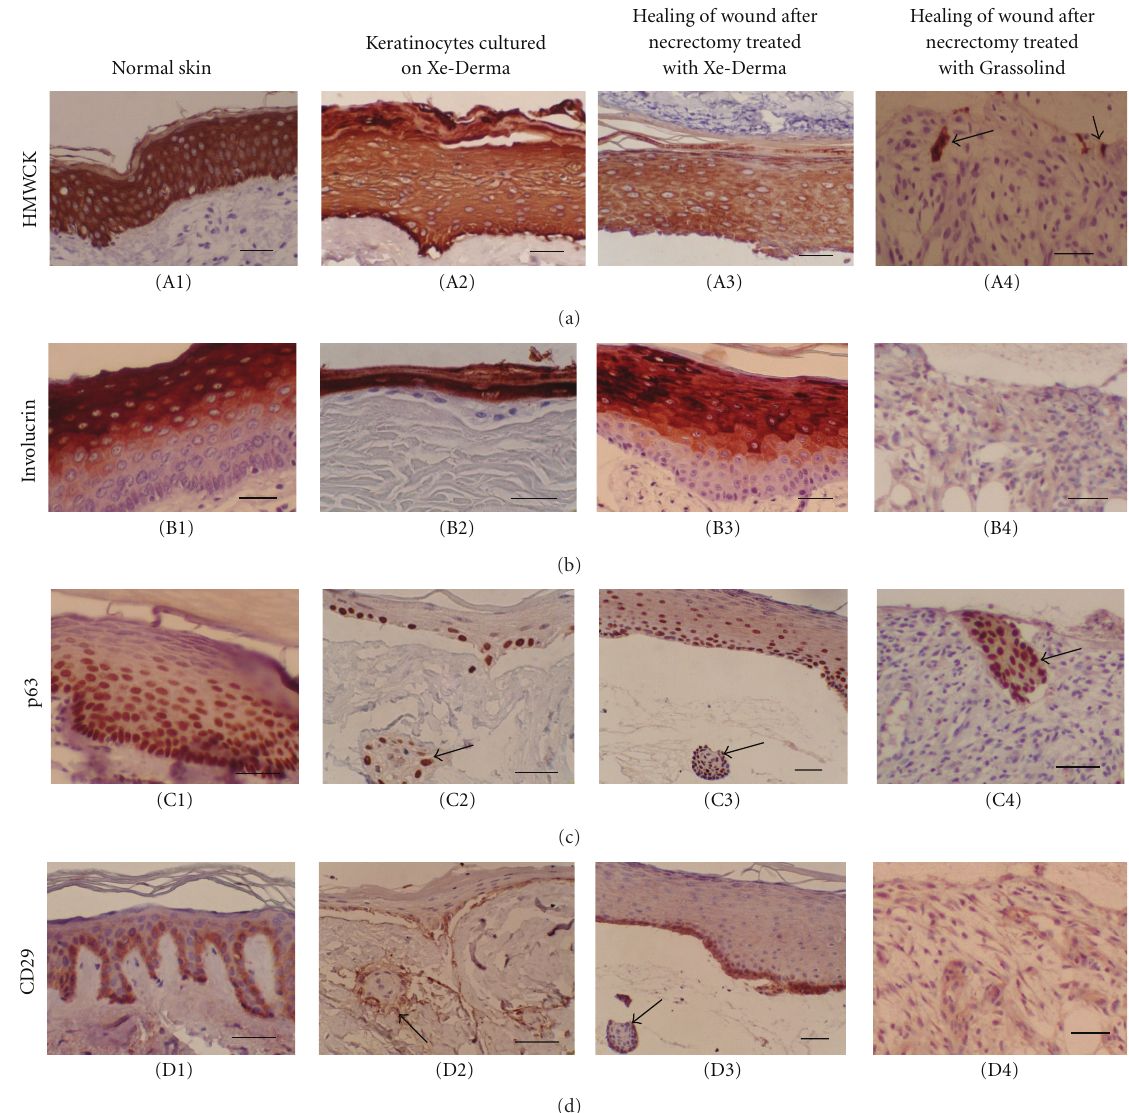
Figure 6: Expression of di ff erentiation markers of the keratinocytes cultured on XD at the air-liquid interface (A2, B2, C2, D2) compared to the normal skin (A1, B1, C1, D1), to freshly healing wound after necrectomy treated with XD (A3, B3, C3, D3), and to freshly healing wound after necrectomy treated with Grassolind (A4, B4, C4, D4). The wounds after necrectomy were covered with XD (column 3) or tulle gras Grassolind (column 4). On day 8 after treatment, biopsies were taken. The expression of di ff erentiation markers HMW CK (a), involucrin (b), p63 (c), and CD29 (d) was compared in the normal skin (column 1), in keratinocytes cultured on XD (column 2), in the wound treated with XD (column 3), and in the wound treated with Grassolind as a control (column 4). The figures show that keratinocyte growth, and di ff erentiation in vitro on XD (column 2) and in vivo epithelization under XD (column 3) is similar and that the wound covered with XD formed epidermis within one week (column 3), while the wound covered with Grassolind did not epithelize (column 4), although remnants of keratinocytes (A4) or adnexa remnants (C4) are visible in the dermis (arrows). Note that cells migrated into the XD matrix formed islands resembling primitive gland-like structures (C2, D2—arrows); they are p63 − in the centre and p63+ at the outer margin of the colony (compare to gland remnants in C3 and D3—arrows). Bars—50 μ